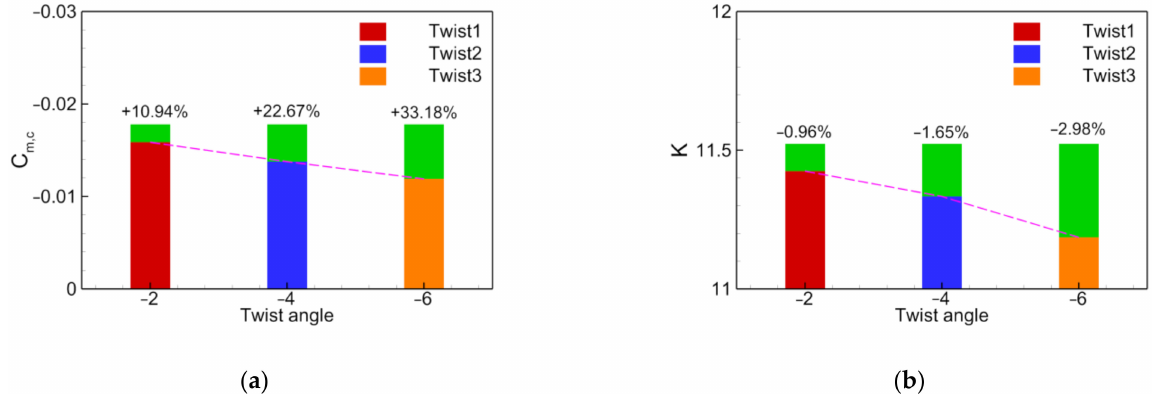
Figure 14. The increments of C m,c and K obtained by twisting the wing at cruise state.( a ) Pitching moment coefficient; ( b ) Lift-to-drag ratio.